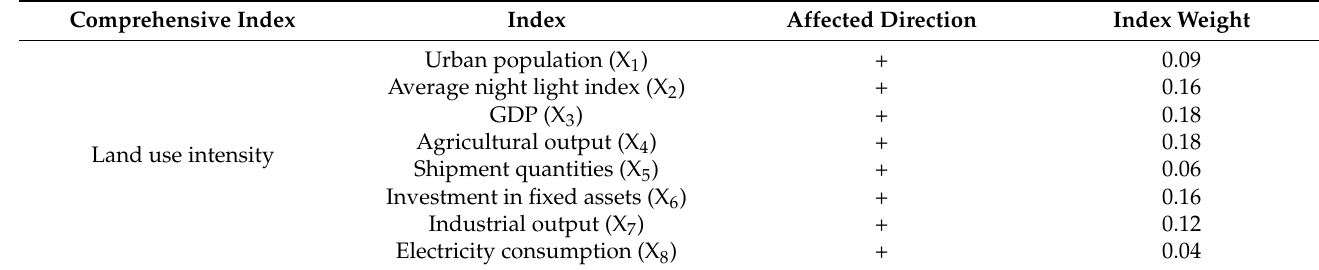
Table 2. Main indices of the land use intensity